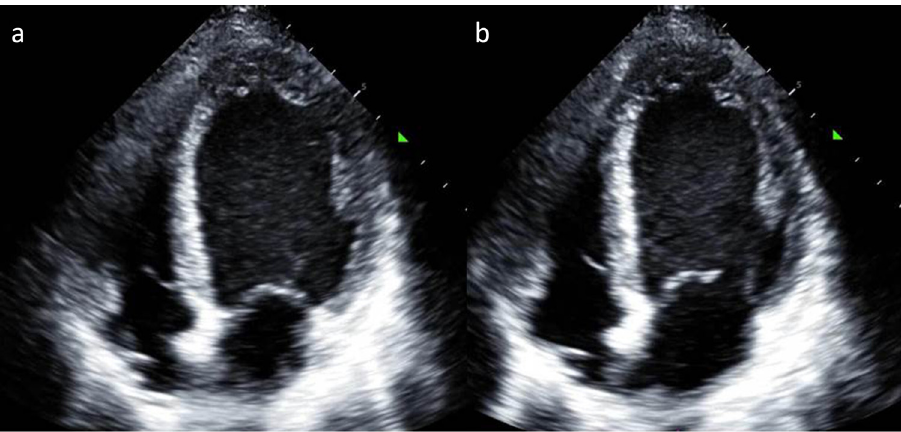
Figure 2: TTE. No motion in the basal and mid segments of the left ventricle but preserved apical wall motion (( a ) in systole and ( b ) in diastole ) .